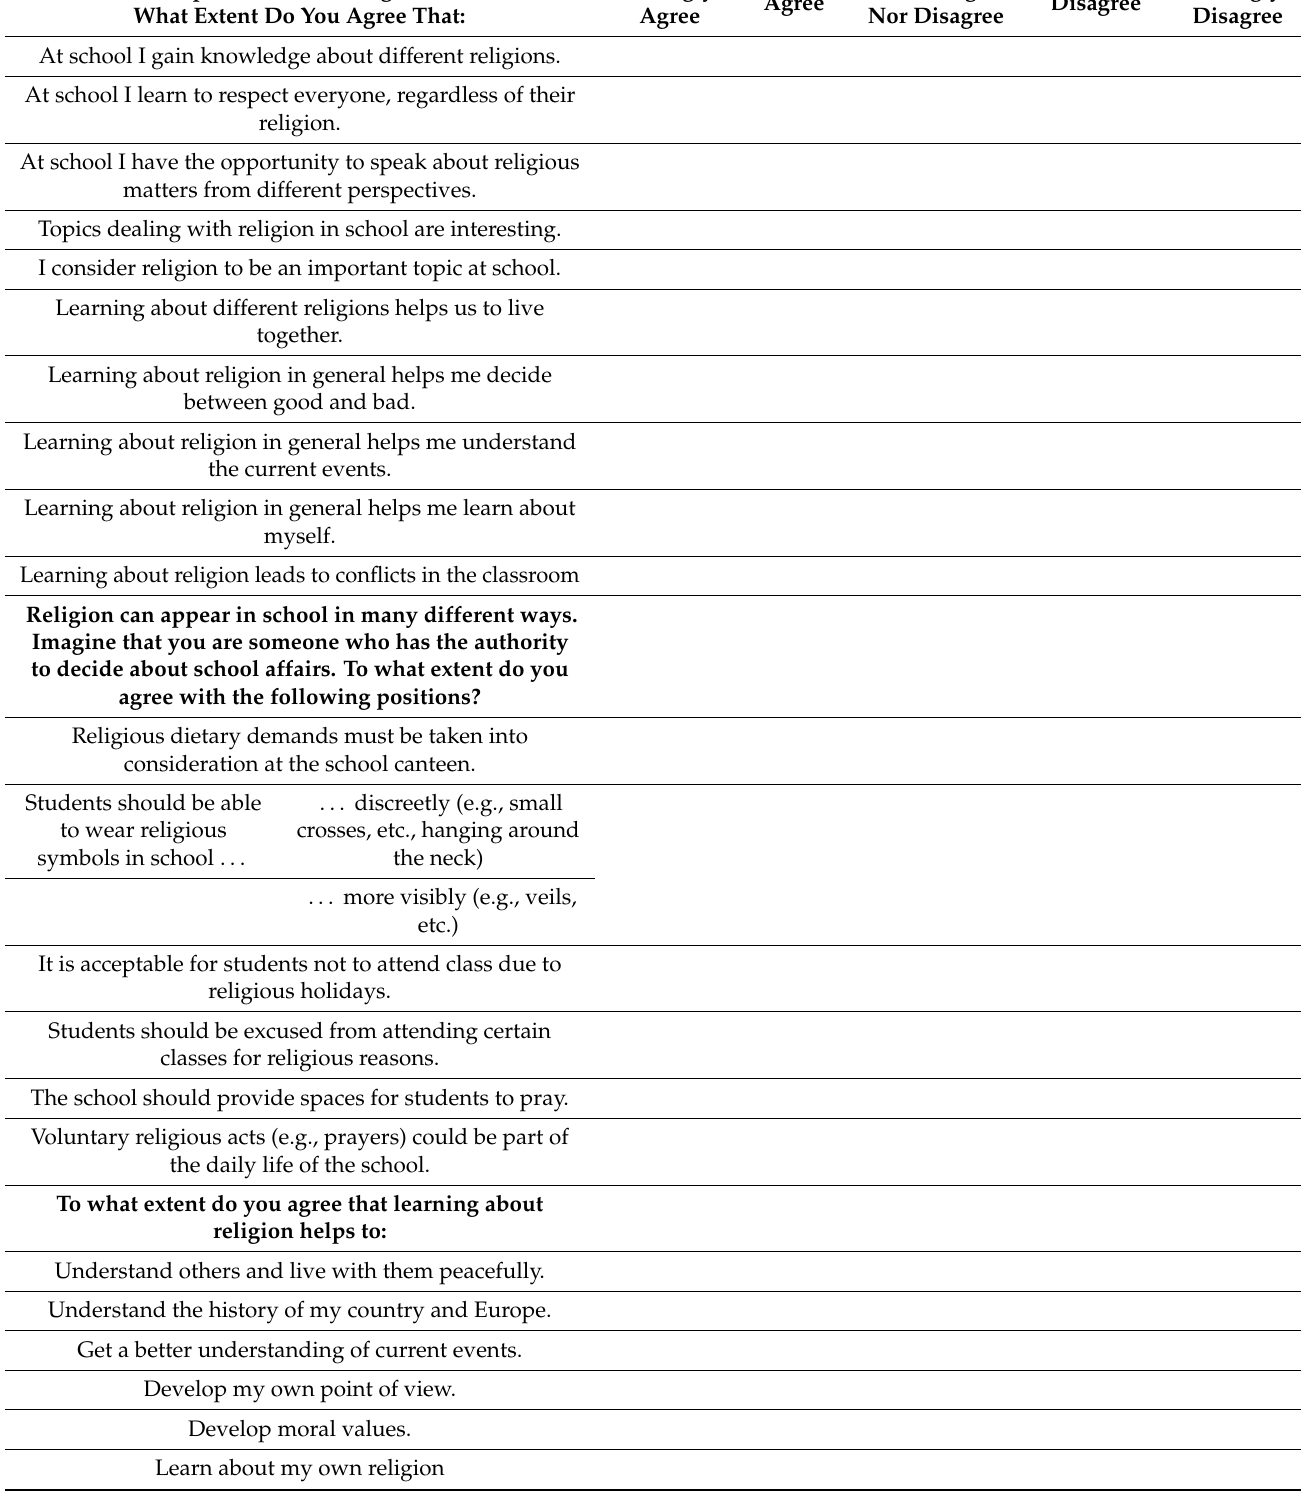
Table A1. Religion, interrelationship and opinion in children and adolescents (RIOCAQ) Questionnaire. What Is Your Experience with Religion in School? To Strongly